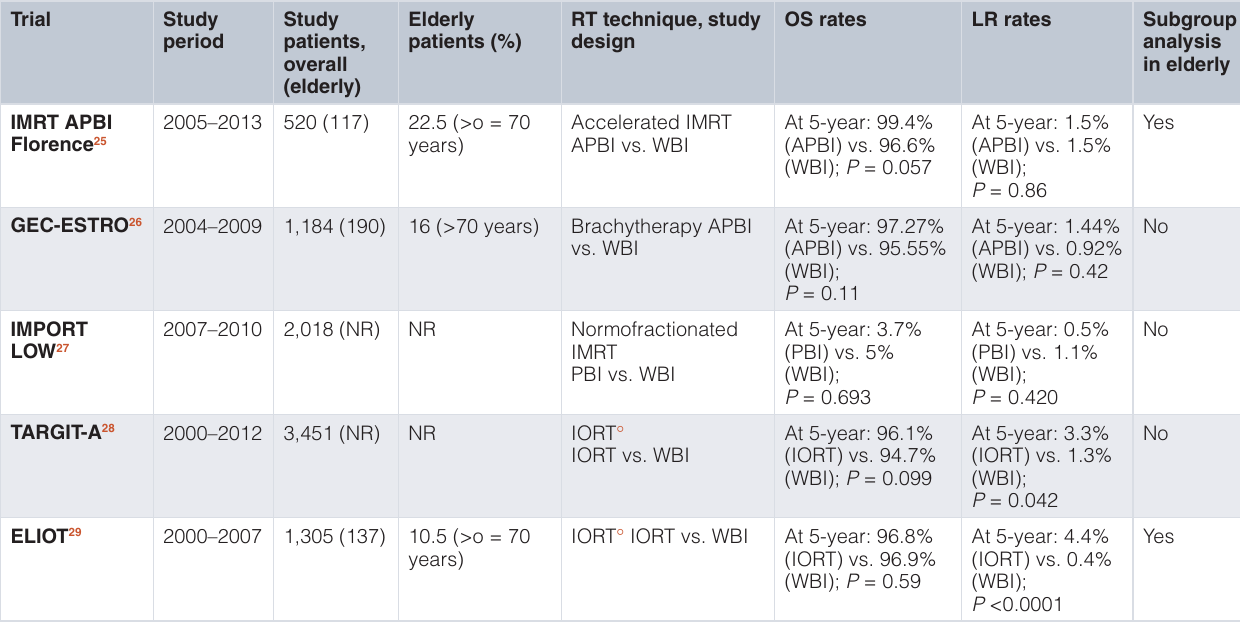
Table 2. Phase III trials investigating partial breast